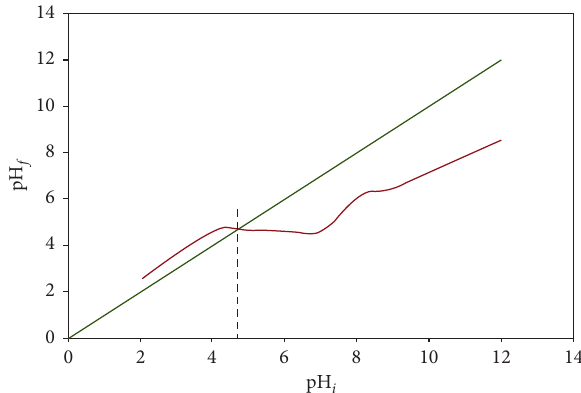
Figure 2: Point of zero charge (pH